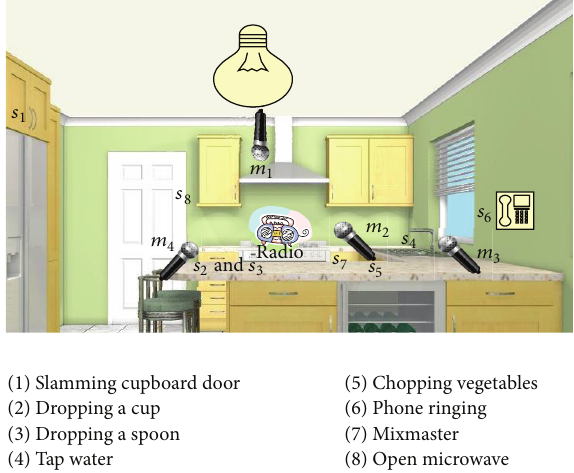
Figure 11: Kitchen configured for data collection to investigate more difficult microphone configurations.